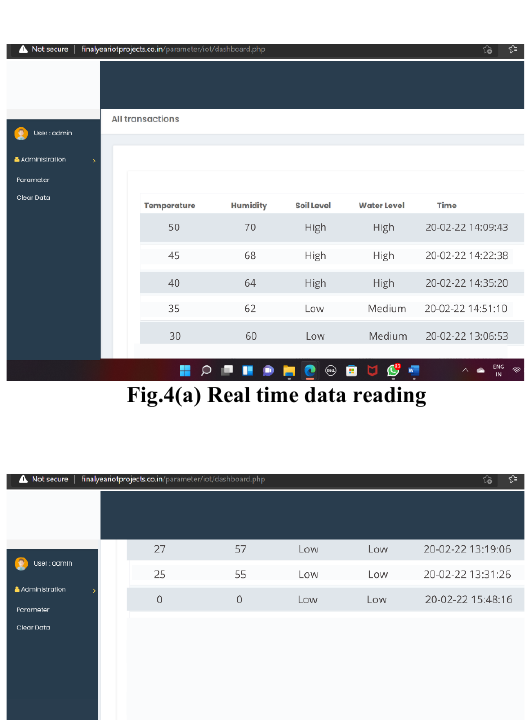
Fig5.(a)IoT website